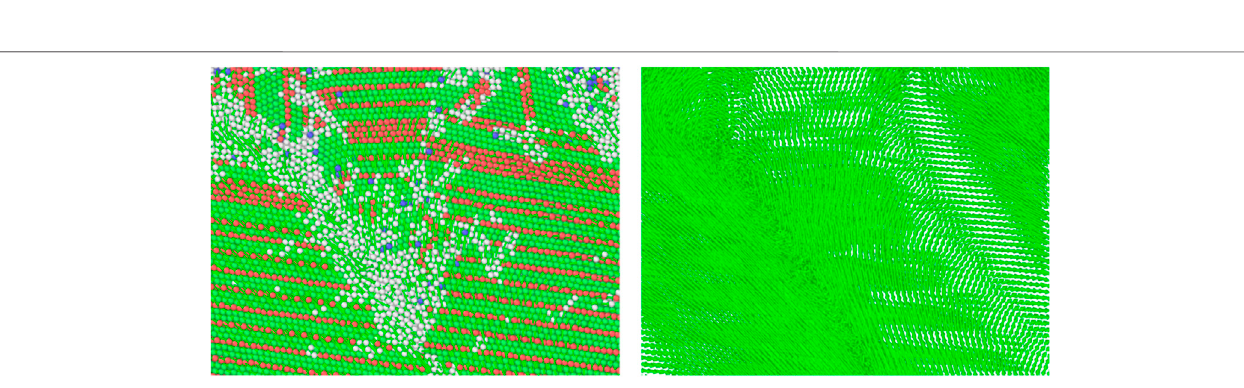
Frontiers in Materials |